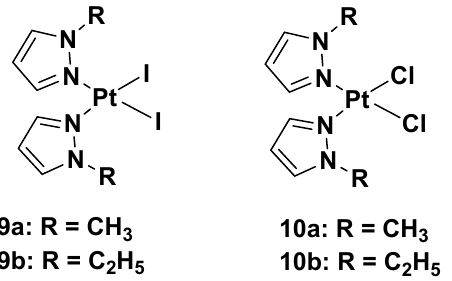
Figure 7. Platinum(II) diiodide complexes and platinum(II) dichloride complexes.